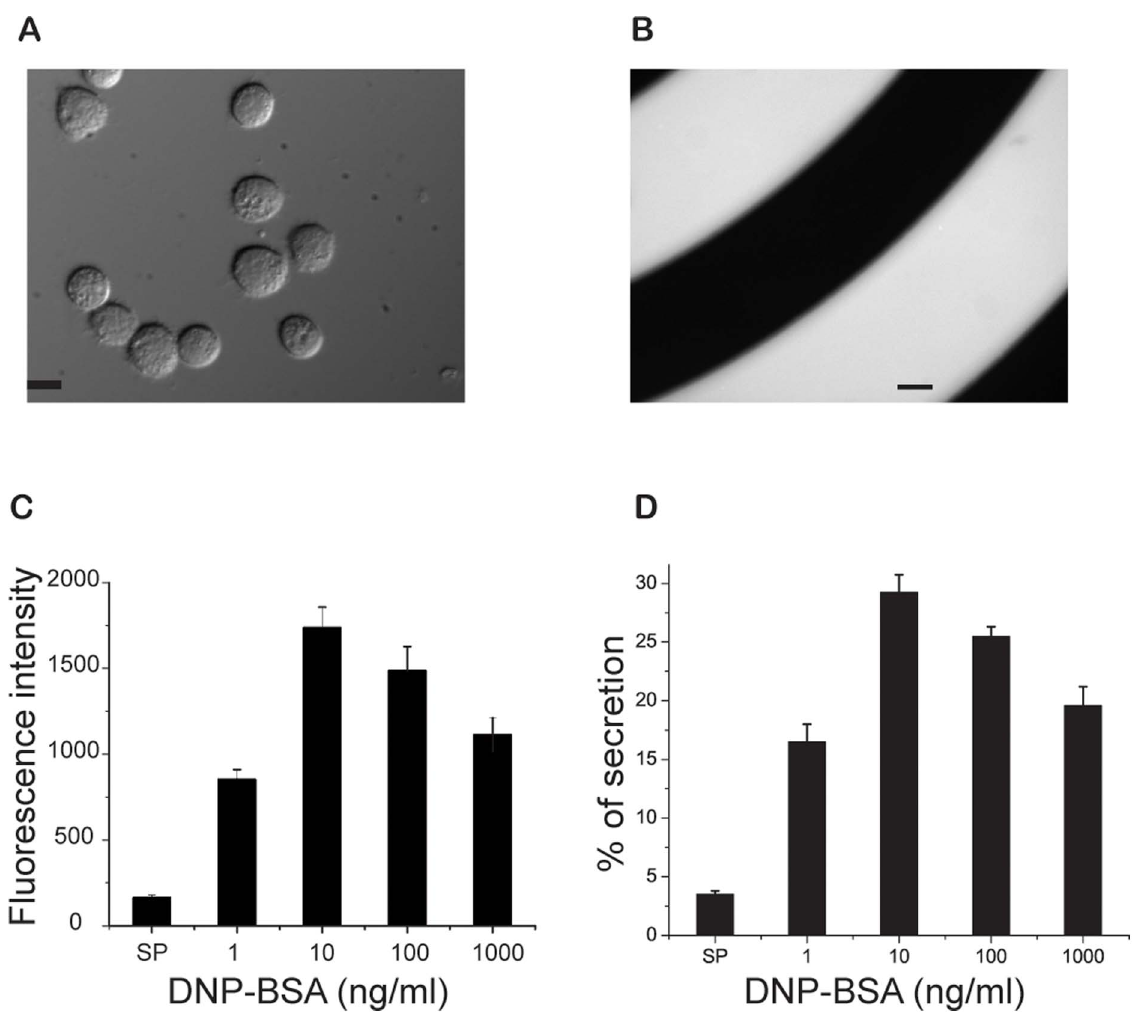
Figure 5. Microscopic measurement of released b -hexosaminidase in microfluidic channels. A) Differential interference contrast (DIC) image of representative live RBL-2H3 cells stimulated with DNP-BSA with no addition of MUG, the fluorogenic substrate of b -hexosaminidase. Scale bar: 10 m m. B) Fluorescence images of live stimulated cells 20 min after addition of both DNP-BSA and MUG. The cells were immersed in supernatant containing released b -hexosaminidase and the fluorescent product methylumbelliferone. The fluorescence signal reveals the spiral geometry of the microfluidic channel. Scale bar: 20 m m. C) A bell-shaped dose-response curve characterizes the degranulation response of live RBL-2H3 cells in microfluidic channels to antigen stimulation. The concentrations of antigen (DNP-BSA) used to stimulate cells ranged from 1 to 1000 ng/ml. D) Results of conventional degranulation assays performed using 24-well tissue culture plates.